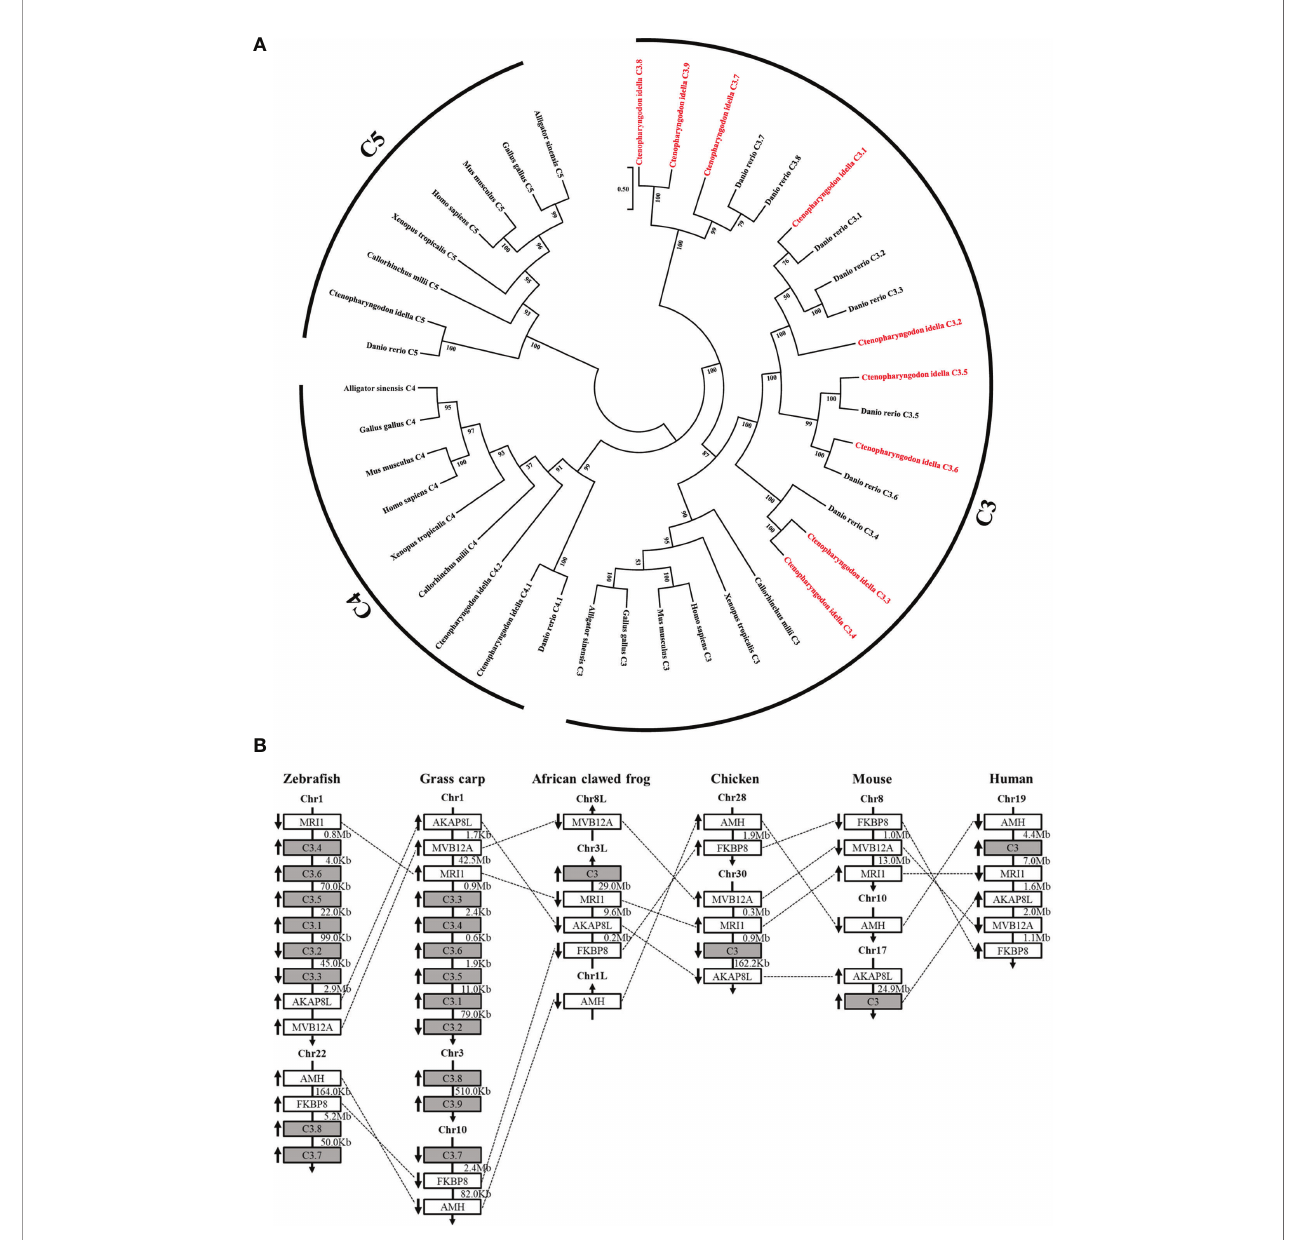
FIGURE 1 | Relationship of grass carp C3 genes with the known C3 , C4 , and C5 genes from representative vertebrates. (A) Phylogenetic relationship of the nine C3 proteins from grass carp with the known C3, C4, and C5 from representative vertebrates. The phylogenetic tree based on protein sequences was constructed using the neighbor-joining method bootstrapped 1000 times with the MEGA program. Grass carp C3.1-C3.9 are shown in red. GenBank accession numbers of the used sequences are shown below: Ctenopharyngodon idella C3.1, OL444976; C. idella C3.2, OL444977; C. idella C3.3, OL444978; C. idella C3.4, OL444979; C.. idella C3.5, OL444980; C. idella C3.6, OL444981; C. idella C3.7, OL444982; C. idella C3.8, OL444983; C. idella C3.9, OL444984; C. idella C4.1, MG599708; C.. idella C4.2, MG599709; C. idella C5, MT150869; Danio rerio C3.1, NP_571317.1; D. rerio C3.2, NP_571318.1; D. rerio C3.3, NP_001032313.1; D. rerio C3.4, XP_002660623.2; D. rerio C3.5, XP_002660624.2; D. rerio C3.6, NP_001008582.3; D. rerio C3.7, NP_001093490.1; D. rerio C3.8, NP_001093483.1; D. rerio C4.1, XP_005157429.1; D. rerio C5, XP_001919226.4; Homo sapiens C3, EAW69070.1; H. sapiens C4, AAI44547.1; H. sapiens C5, NP_001726.2; Mus musculus C3, NP_033908.2; M. musculus C4, XP_006523594.1; M. musculus C5, NP_034536.3; Gallus C3, AAA64694.1; G. gallus C4, NP_001070701.1; G. gallus C5, XP_415405.5; Callorhinchus milii C3, XP_042200573.1; C. milii C4, XP_042200730.1; C. milii C5, XP_007900925.2; Xenopus tropicalis C3, XP_031755334.1; X. tropicalis C4, NP_001107156.1; X. tropicalis C5, NP_001190988.1; Alligator sinensis C3, XP_006023407.1; A. sinensis C4, XP_025048727.1; A. sinensis C5, XP_014382164.1; (B) Synteny analyses of grass carp C3 genes with other vertebrate C3 genes. C3 genes are indicated by solid grey boxes. Arrows indicate gene transcription orientations. Chr,